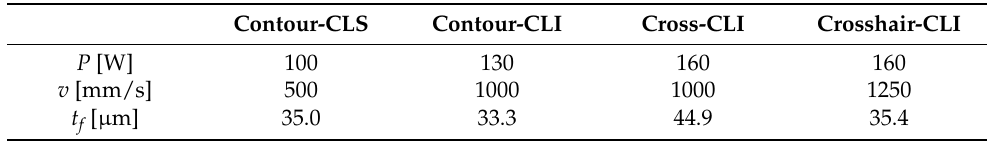
Table 1. Selected optimum parameters for laser power P and scanning speed v for each scanning strategy and the respective average metallurgic fusion depth t f .